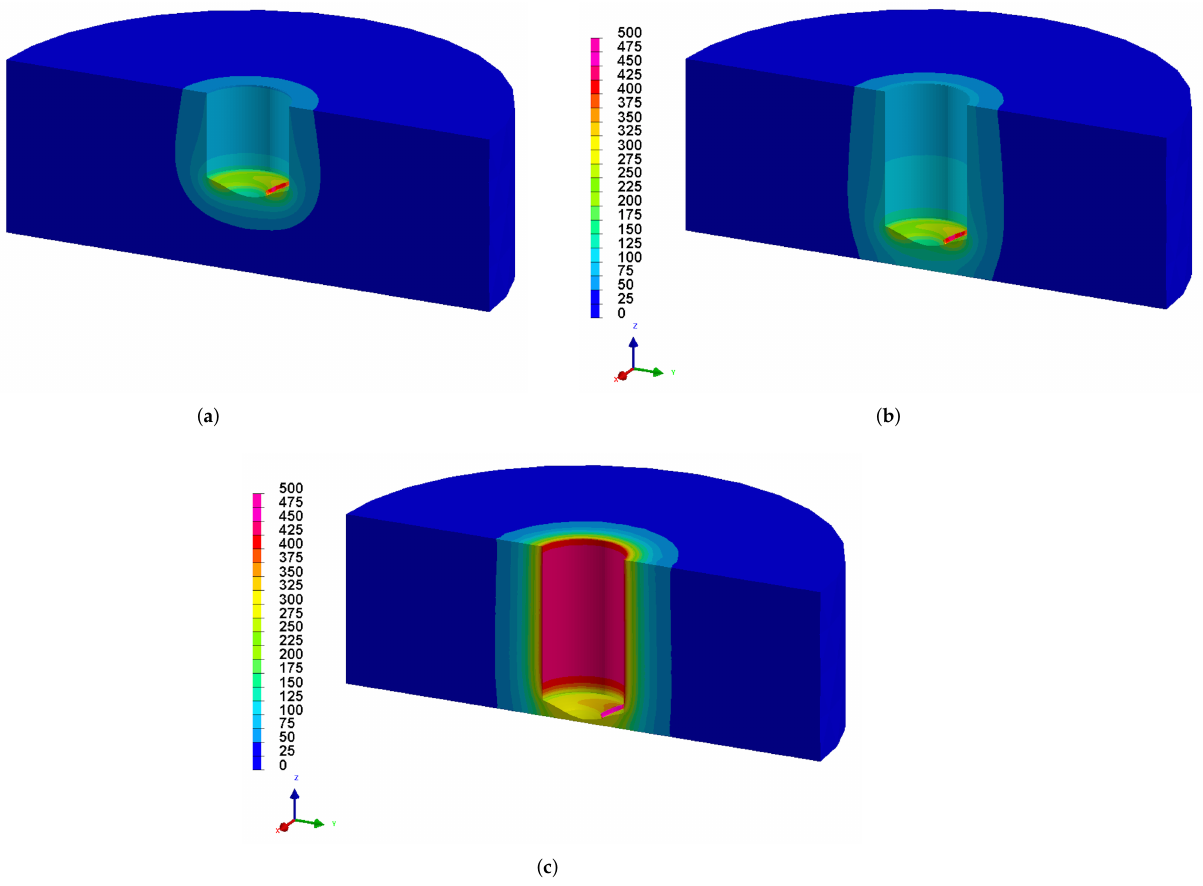
Figure 14. Temperature evolution ( ◦ C) simulated during the dry drilling operation: ( a ) phase 1 ( t = 6.7 s); ( b ) phase 2 ( t = 10 s); and ( c ) phase 3 (time